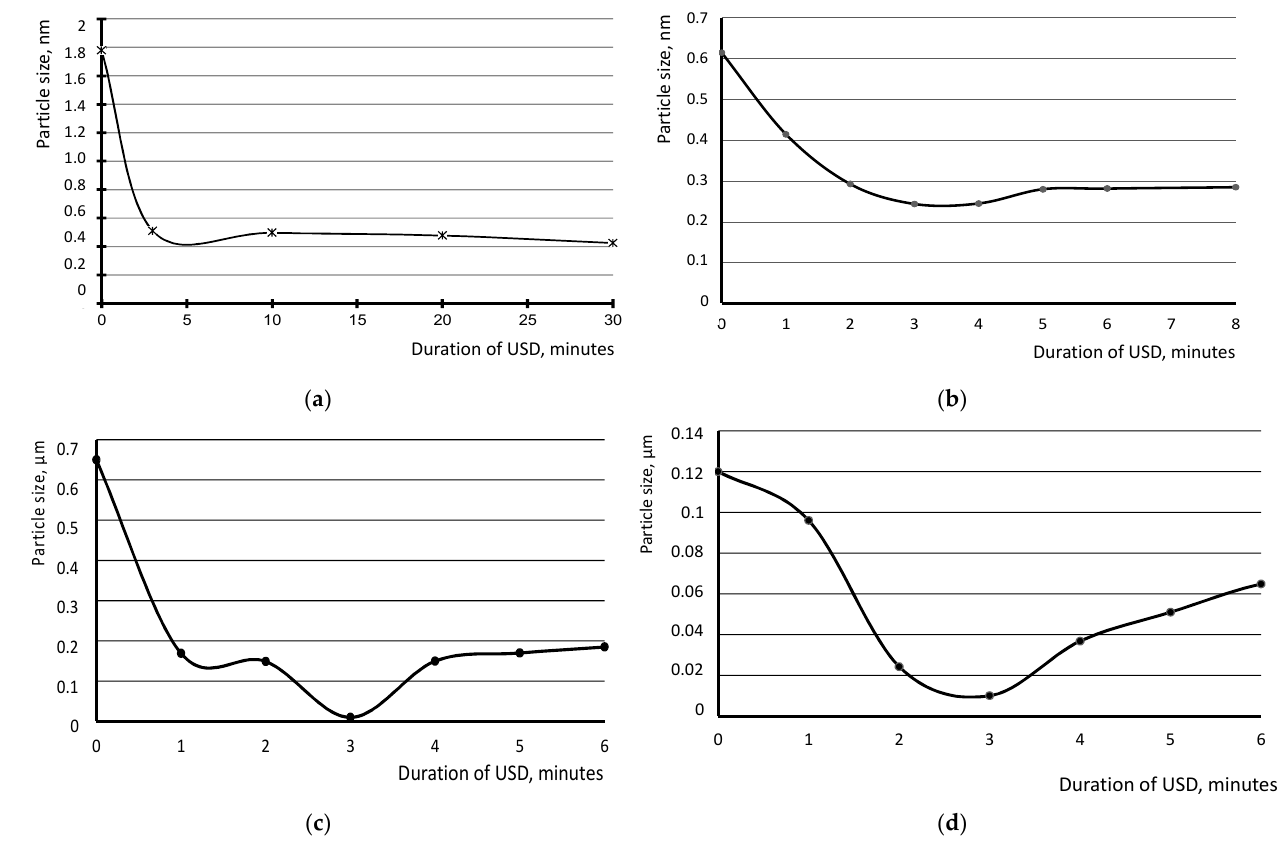
Figure 7. Change in the average particle size from the duration of the USD: ( a ) aqueous (MFN and Sulfanol); ( b ) aqueous (CNPLUS and ViscoCrete 2100); ( с ) organic (MWCNT and industrial oil); ( d ) organic (MWCNT-MD and RSPE).